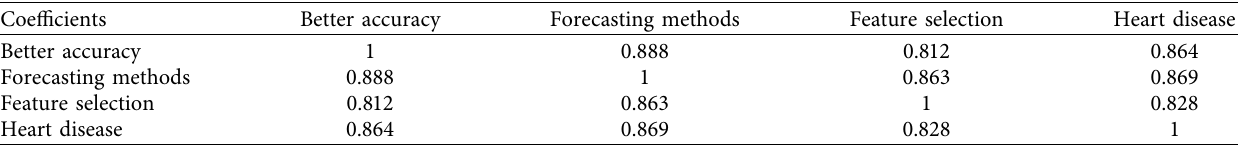
Figure 3: medical support. Table 4: coefficient of correlation analysis.